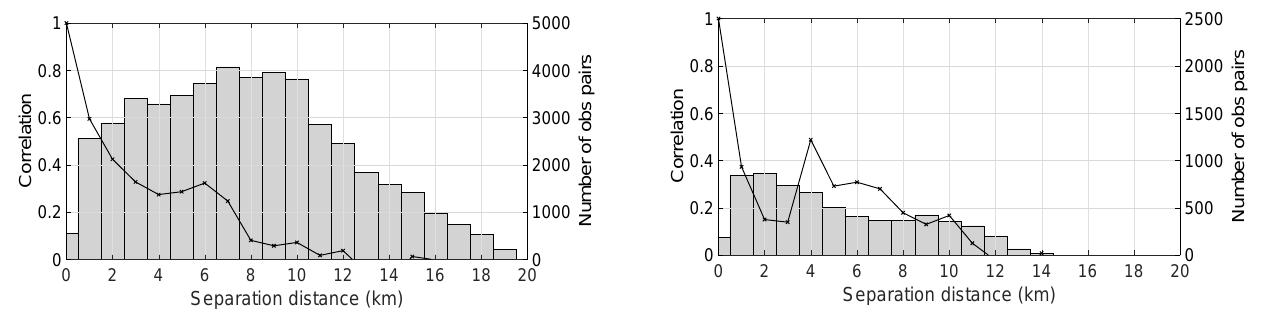
Figure 2. Estimated SAR WLO error correlations (black line) and number of samples (bars) used for the calculation. Estimated error standard deviation is 54cm.